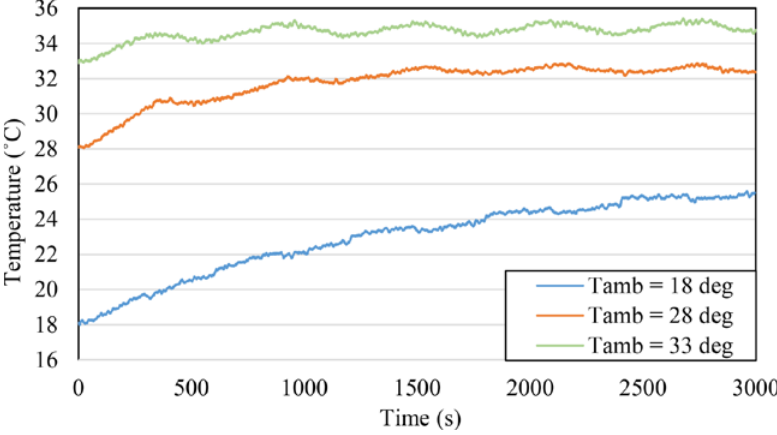
Figure 6. Variation in battery surface temperatures with different ambient temperatures (from Alihosseini and Shafaee [53], with permission from Elsevier).